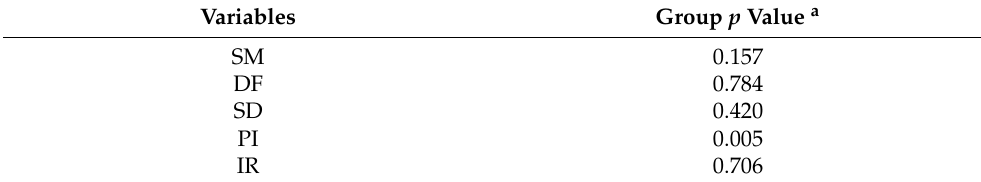
Table 5. Mann–Whitney U